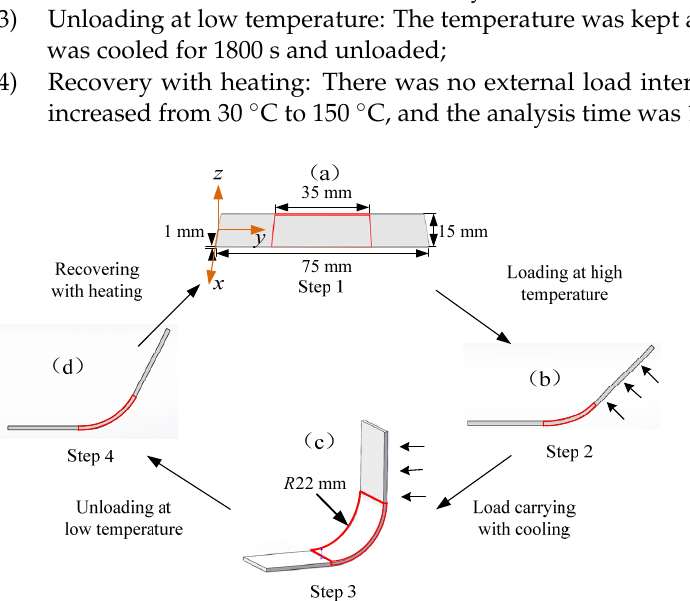
Figure 17. Shape memory flow chart for E-SMP: ( a ) the initial or permanent state; ( b ) the state of loading at high temperature; ( c ) the state in which one end is bent to 90°. The shape of S-DS recovers from state ( d ) to state ( a ) under thermal effect, when the S-DS samples are heated by electrification.